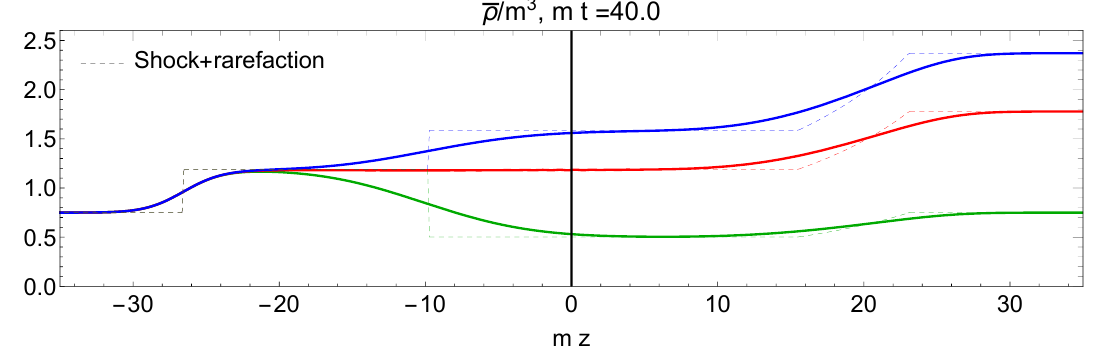
Figure 10: We show a snapshot of the charge density at t = 40 for a temperature ratio of χ = 16 / 9 and three different ratios of the charge density, with n 256 / 81, 64 / 27 and 1 for the blue, red and green curves respectively. In general there are two regions of constant charged, determined solely by χ and n regions almost coincide for the 64 / 27 ratio, but are different for the blue and green evolutions. For comparison we again show the analytical shock + rarefaction solutions of Section 2